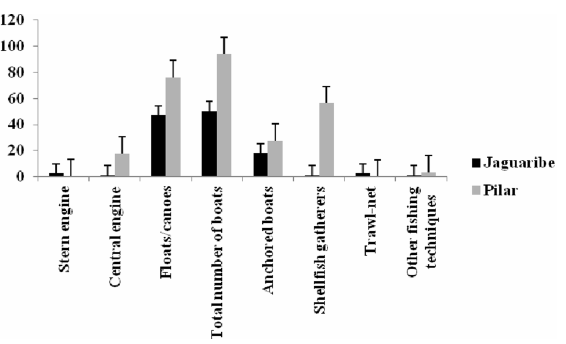
Figure 2. Main forms of anthropogenic impact recorded at the Jaguaribe and Pilar sites (Itamaracá, Brazil) between July and September 2007 using mean